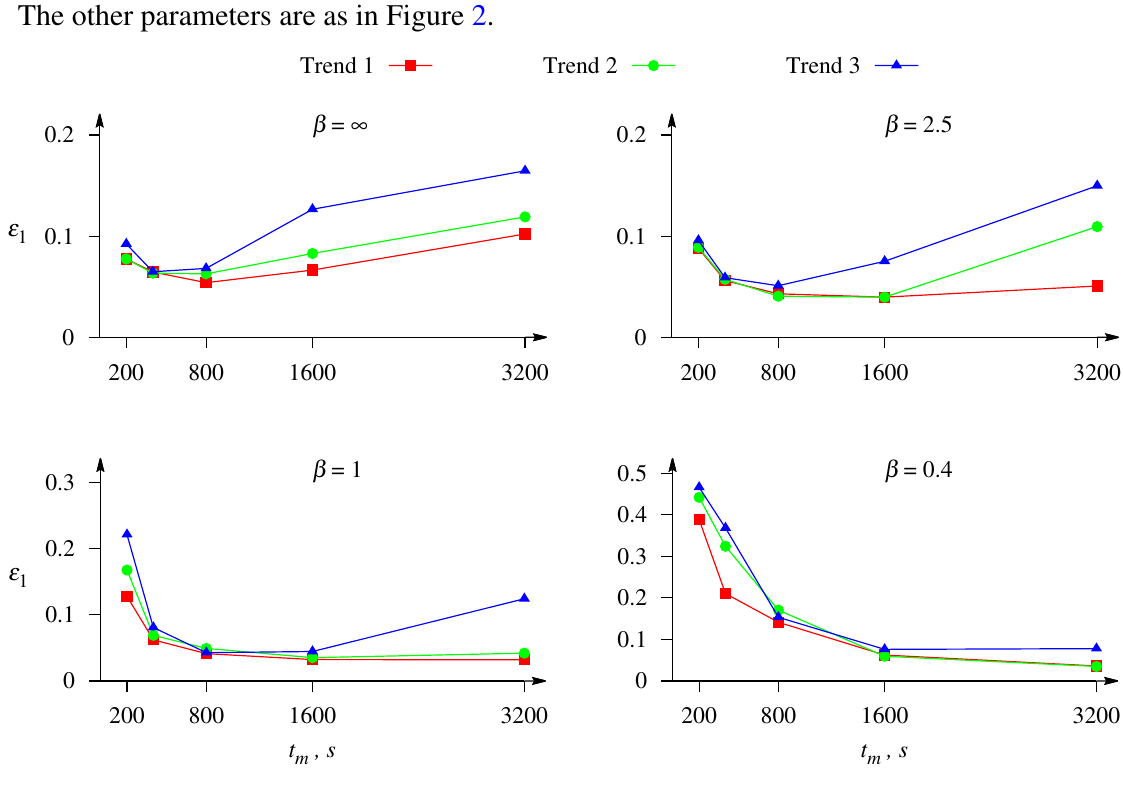
, versus the duration, 1